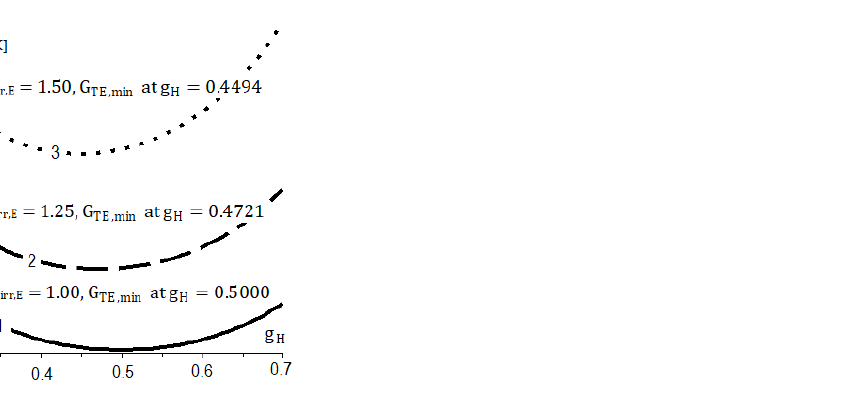
Figure 10. Dependence between the thermal conductance inventory and the dimensionless thermal conductance at the hot side G TE = f ( g H